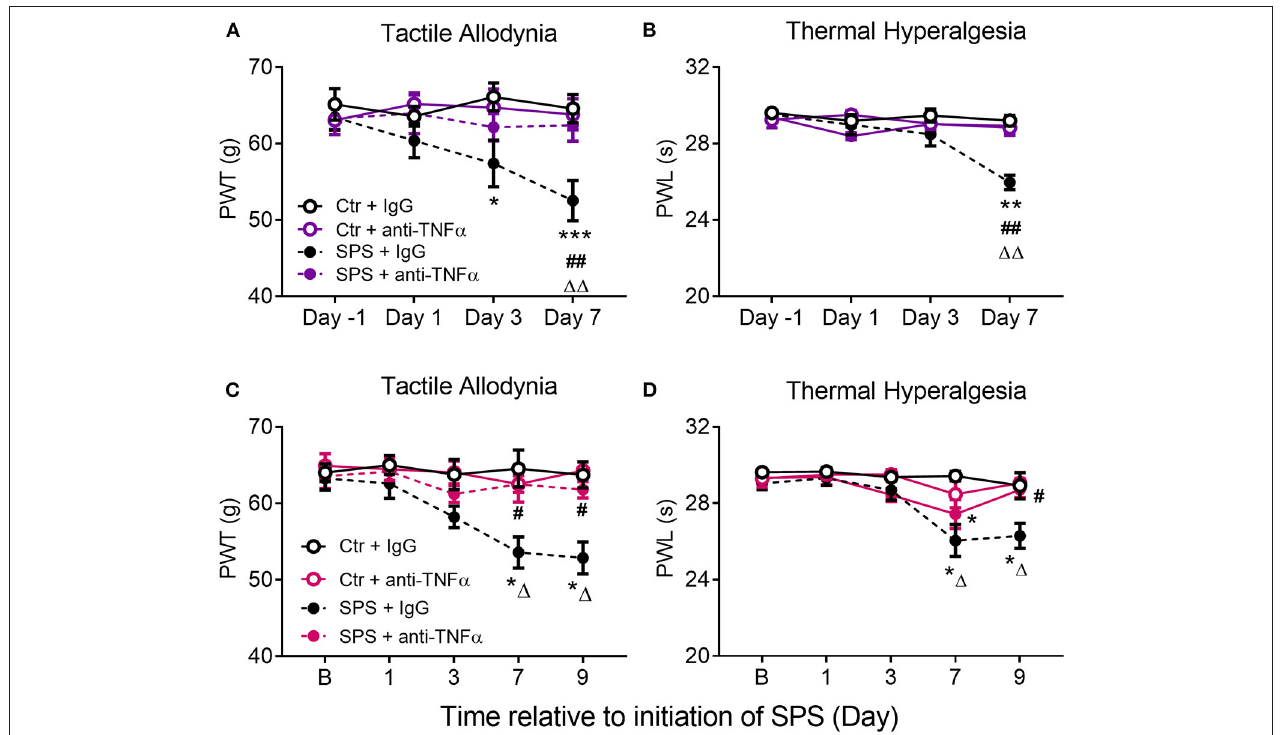
FIGURE 9 | Anti-TNF- α antibody treatment prevents development of SPS-induced tactile allodynia (A,C) and thermal hyperalgesia (B,D) in male (A,B) and female (C,D) rats. Rats received a single injection of goat-anti rat TNF- α diluted in saline or the same volume of goat IgG during the SPS procedure. Data are presented as mean ± SEM of 5–6 rats per group. Data were analyzed by two-way ANOVA with Tukey’s multiple comparison test. Significant differences were noted as follows: from control: * p < 0.05, ** p < 0.01, *** p < 0.001; from Ctr+anti-TNF α : 11 p < 0.01, 111 p < 0.001; and from SPS: # p < 0.05, ## p < 0.01.